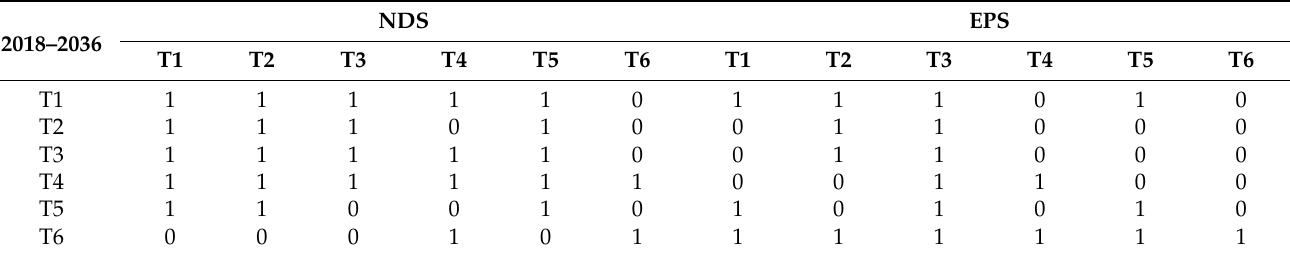
Table 1. Simulation cost matrix of each